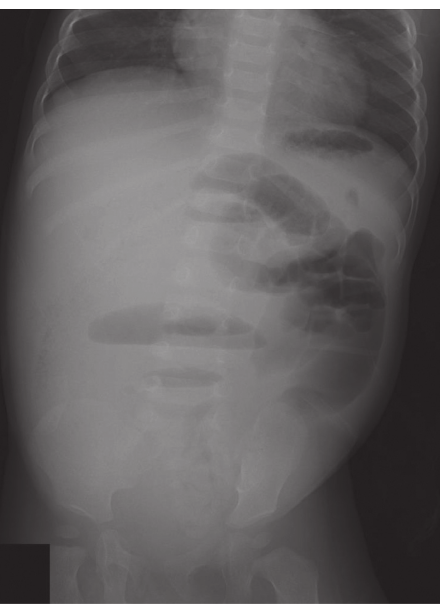
Figure 1: An abdominal X-ray scan demonstrated multifocal air- fluid levels.